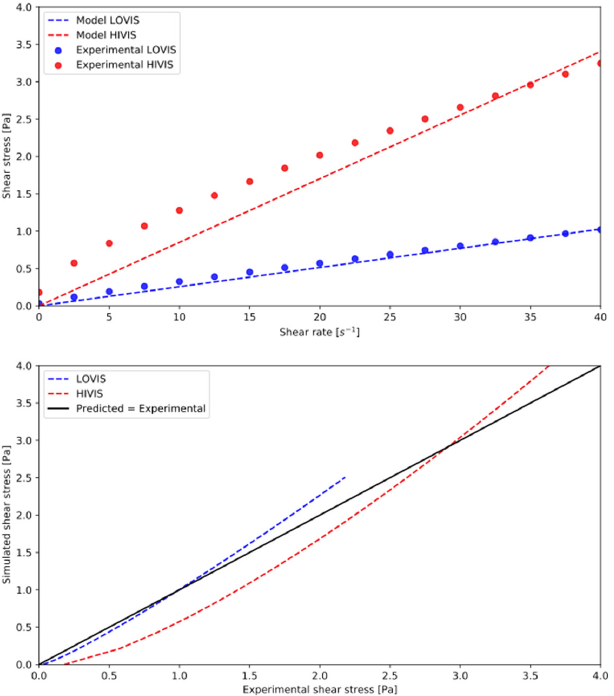
Figure 6. Rheological behavior of LOVIS and HIVIS fluids in the DCM and the simulated counterparts in silico. Rheological measurements were carried out at 25 °C.